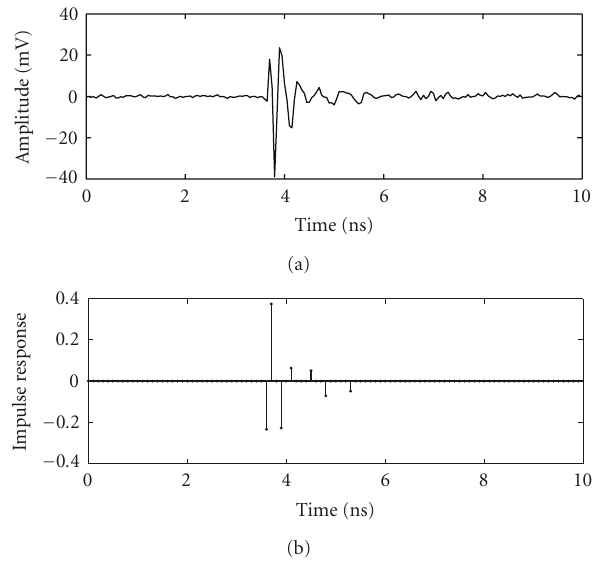
Figure 7: Example of received waveform and the corresponding CIR for under chassis